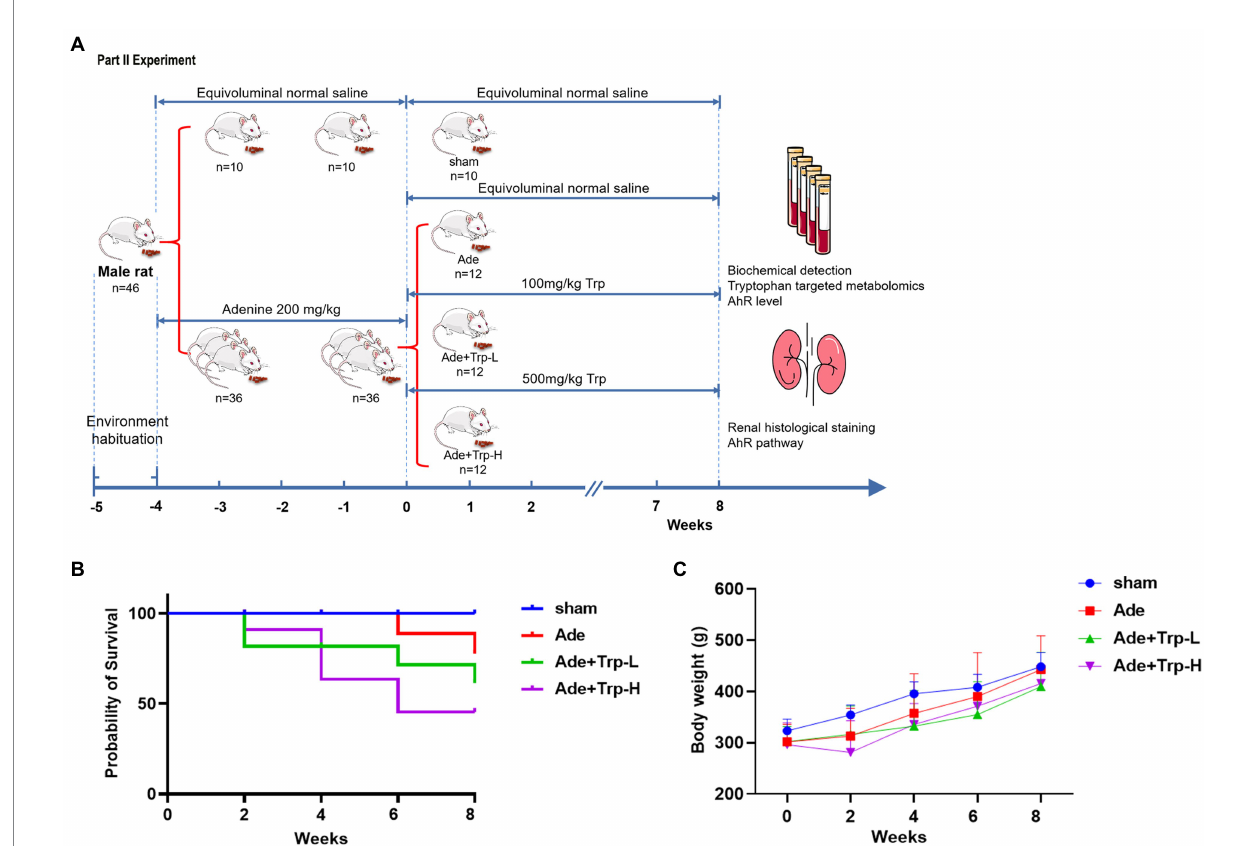
FIGURE 2 Effect of tryptophan in adenine-induced CKD rats. (A) Schedule of Part II experiment. (B) Probability of survival. (C) Body